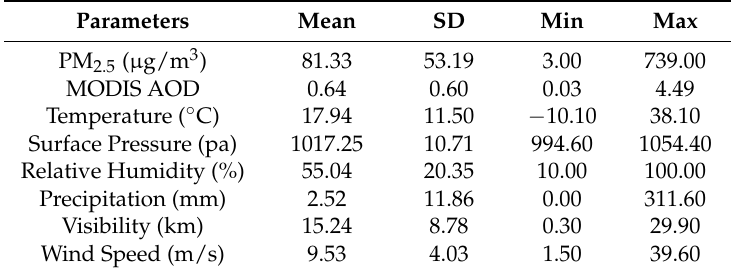
Table 2. The details of PM 2.5 measurements and the model input parameters.